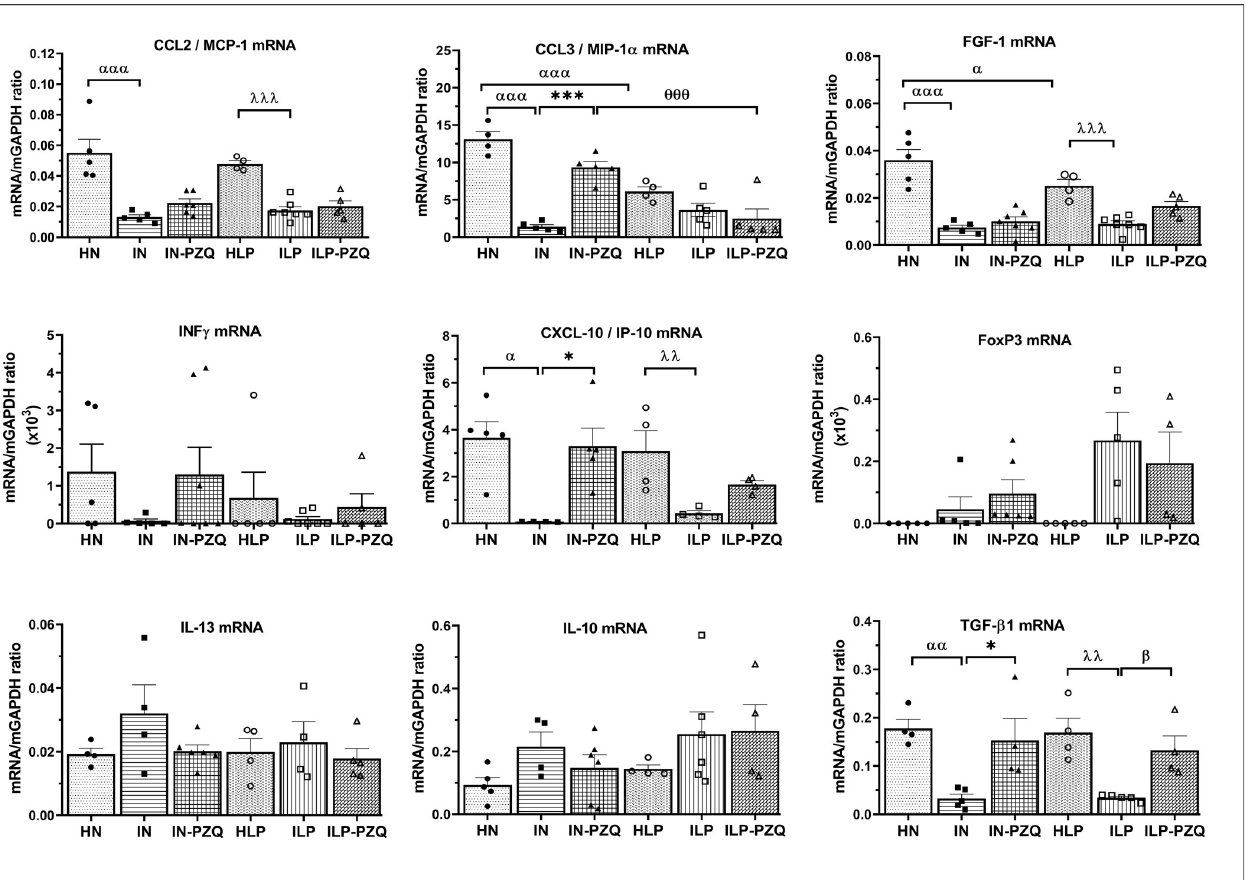
Fig 9. Effects of praziquantel treatment on the mRNA expression of cytokines and chemokines of Schistosoma mansoni -infected mice receiving a low- protein diet. Data are expressed as mean ± SEM (n = 4–8). Group HN: healthy mice receiving a standard diet; group IN: infected-untreated mice receiving a standard diet; group IN-PZQ: infected mice receiving a standard diet and treated with praziquantel; group HLP: healthy mice receiving a low-protein diet; group ILP: infected-untreated mice receiving a low-protein diet; group ILP-PZQ: infected mice receiving a low-protein diet and treated with praziquantel. ANOVA followed by Turkey multiple comparison test. α P < 0.05; αα P < 0.01; ααα P < 0.001: values are significantly different from healthy mice receiving a standard diet (group HN). � P < 0.05; �� P < 0.001: values are significantly different from infected-untreated mice receiving a standard diet (group IN). λλ P < 0.01; λλλ P < 0.001: values are significantly different from healthy mice received a low-protein diet (group HLP). β P < 0.05; values are significantly different from infected-untreated mice receiving a low-protein diet (group ILP). θθθ P < 0.001: values significantly different from infected mice receiving a standard diet and treated with praziquantel at the dose of 100 mg/kg for 5 consecutive days (group IN-PZQ).